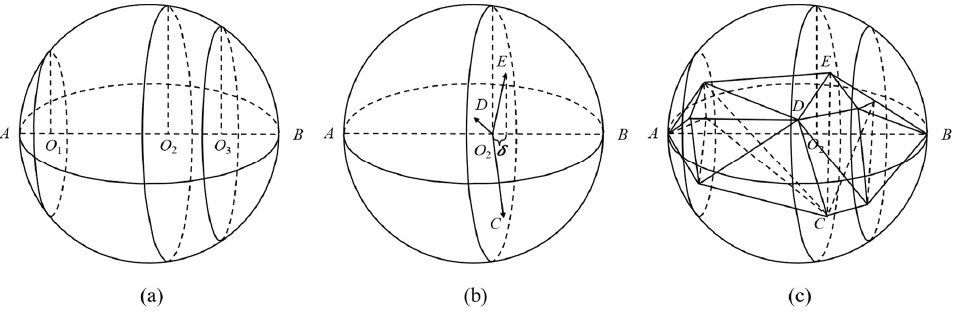
Figure 4. Generation process of rounded grains: ( a ) randomly create intersecting circles; ( b ) randomly select points within the intersected circle and add offset; ( c ) connect all generated vertices and form the grains.